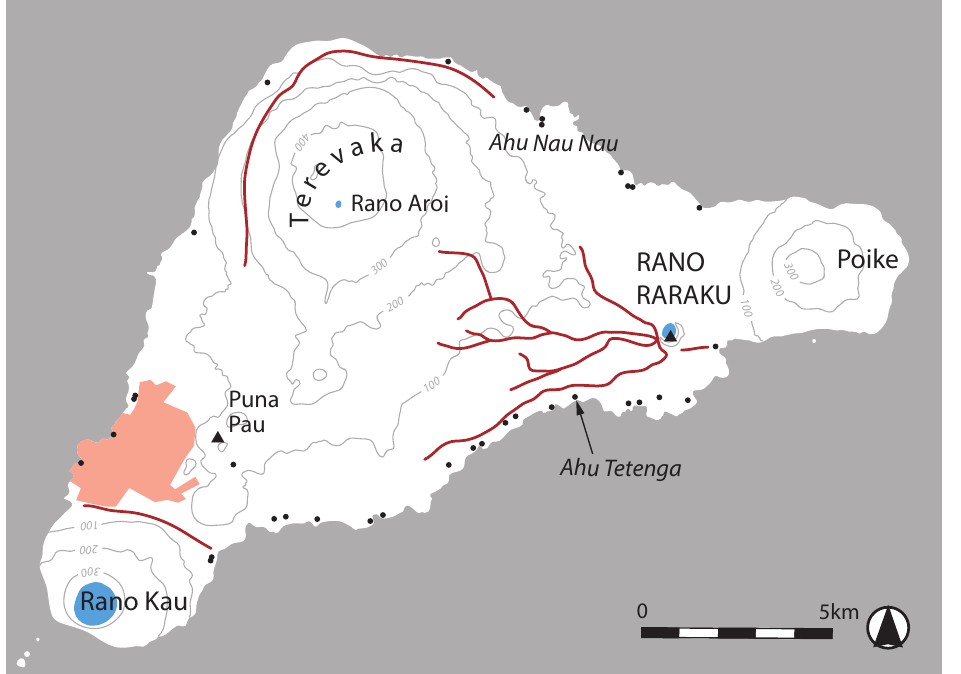
Fig. 2: Map of Rapa Nui, showing the places mentioned in the text, including the statue roads; the area of red shading is the present-day town of Hanga Roa. The locations of some of the major image ahu ( ahu with statues) around the coast are marked by black dots; >100 of the ahu around the coast may originally have had statues, but these are too numerous to depict here (Martinsson-Wallin,